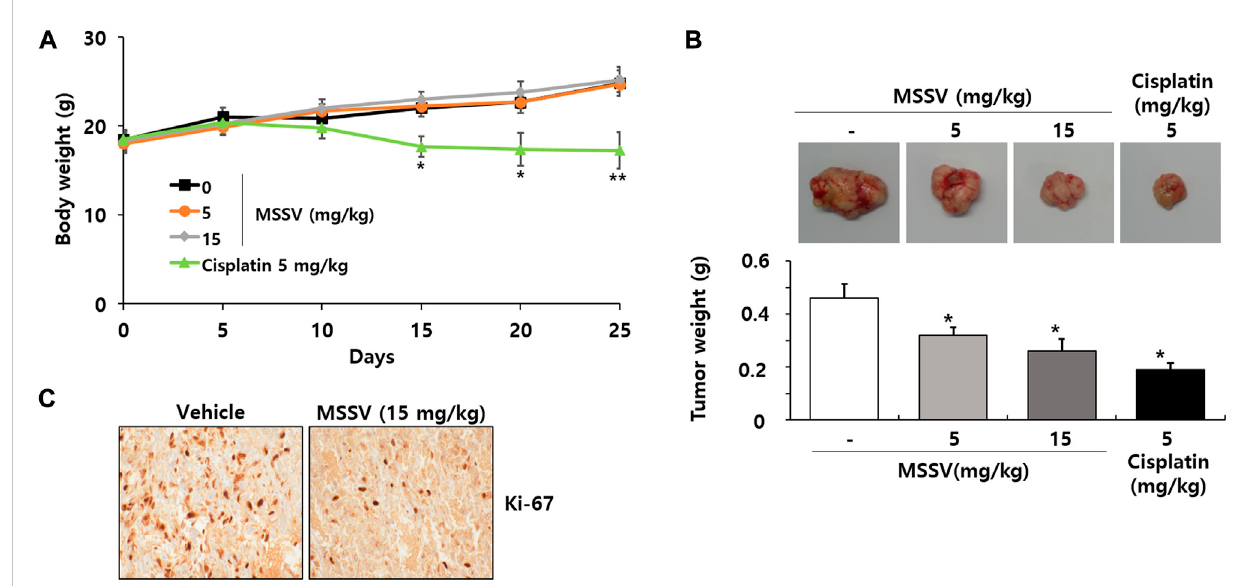
FIGURE 8 Oral injection of MSSV inhibited HCT116 cell growth in xenograft mice (A) Measurement of body weight change in mice after treatment with MSSV (0, 100, 200, and 400 mg/kg) and cisplatin (5 mg/kg). (B) The images and weights of tumors isolated from xenograft mice. (C) Ki-67 staining from tumor tissues. Data are presented as mean ± SD and the * (asterisk) indicates a statistically signi fi cant difference. A p -value of < 0.05 was considered statistically signi fi